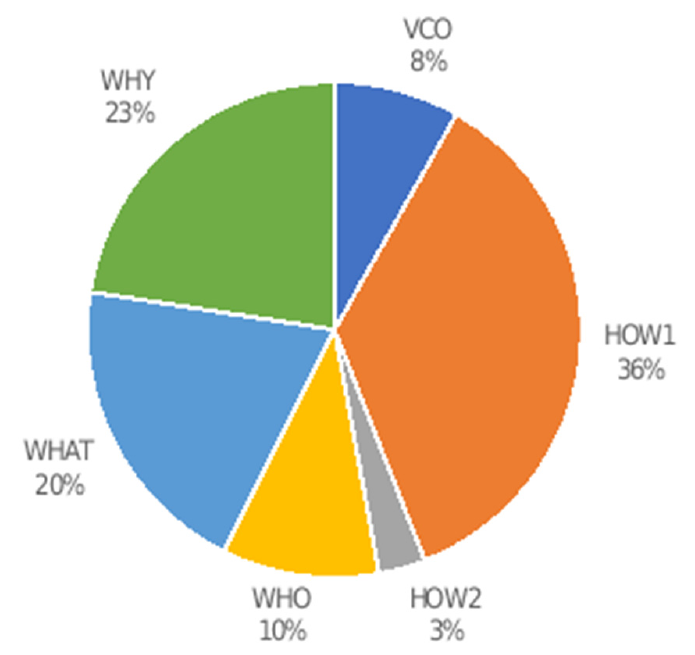
Figure 3. BM COMPANIES in 2019–2020. Own depiction per COMPANIES CR (n = 41). Our research Hypothesis 1 assumes that the structure of the BM elements in the COMPANIES changed in 2020 compared to 2019. By means of the t -test, we tested the Hypothesis 1 1 being that in the examined sample of CR documents ( n = 41) of the COMPA- NIES, the cumulated relative frequencies of the BM 2019 elements (cid:54) = cumulated relative frequencies of the BM 2020. This means that the BM COMPANIES 2019 (cid:54) = BM COMPANIES 2020. At df 39, at the significance level α = 0.05, t (cid:104)− 1.427; − 0.356 (cid:105) and p (cid:104) 0.162; 0.724 (cid:105) , we reject the alternative Hypothesis 1 1 and accept Hypothesis 1 0 being that the BM structure did not